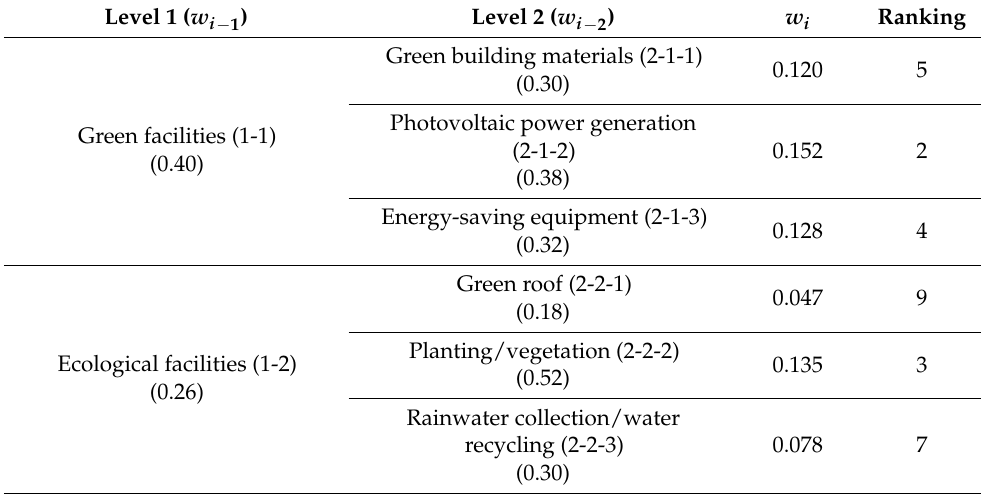
Table 6. Relative weights ( w i ) of factors in this